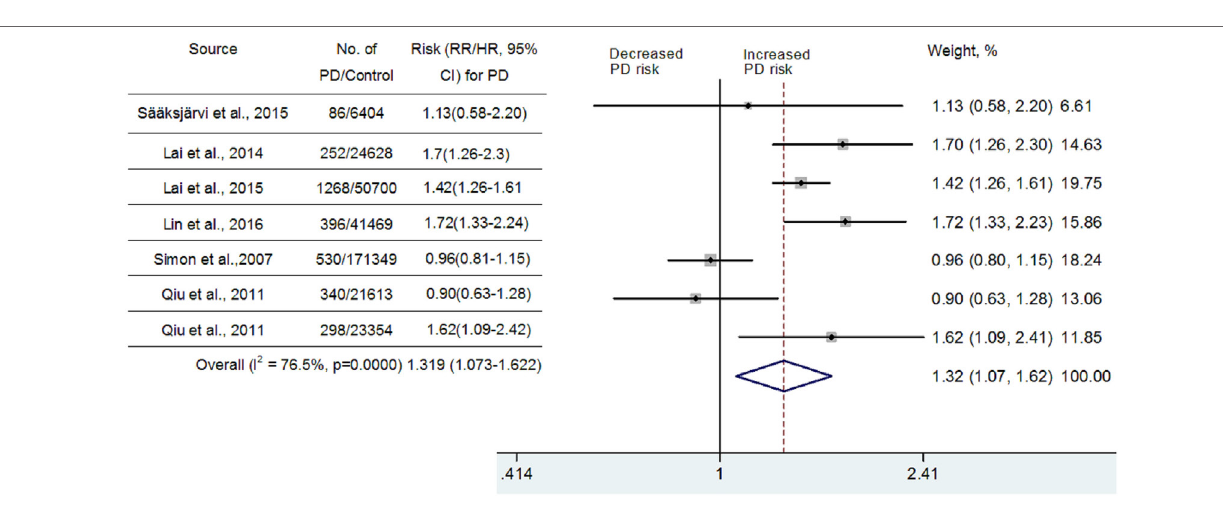
FigURe 3 | Meta-analysis of the association between hypertension and Parkinson’s disease (PD) risk after adjustment for the potential confounding vascular factors.